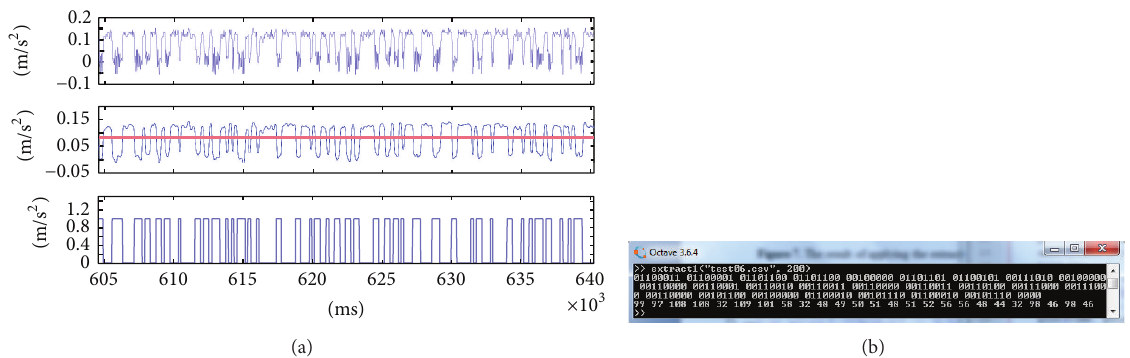
Figure 10: (a) The result of applying the extraction method on modulated acceleration signals from Samsung S2. (b) The decoded bit string and equivalent 7-bit ASCII codes.